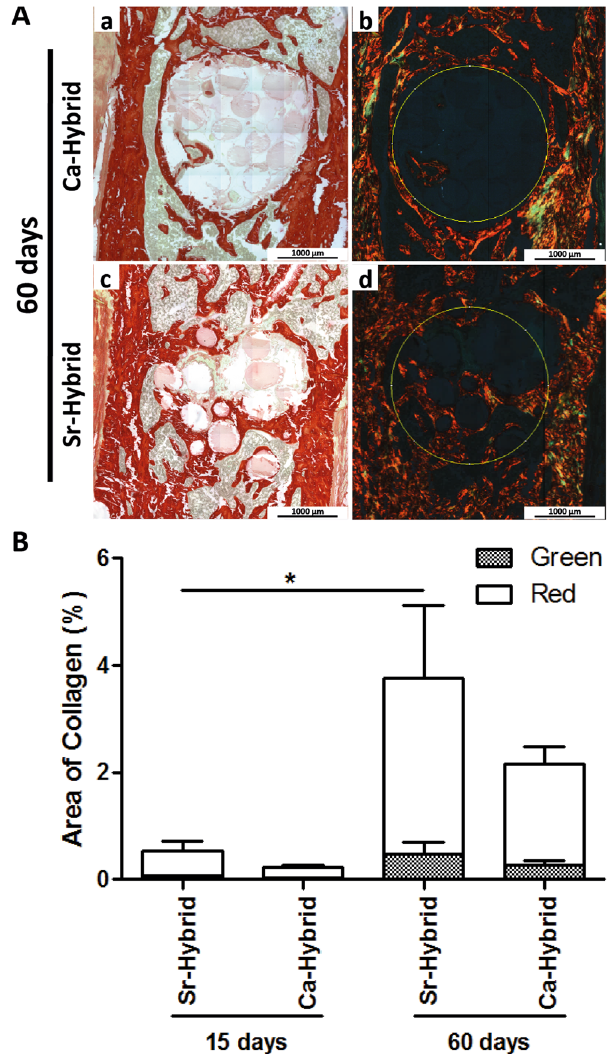
Figure 6. Quantification of birefringent collagen fibers by PSR-polarization method in the center of the defect. PSR staining visualized under conventional light (a and c) and polarized light (b and d) to identify different collagen fiber types, 60 days post-implantation of Ca-hybrid (a and b) and Sr-hybrid (c and d) systems ( A ). PSR stains collagen in red (conventional light) and collagen fibers are specifically birefringent in polarized light (green - thin fibers/type III; red - thick fibers/type I, MosaicX image, original magnification 20x). Fixed region of interest (ROI) used for quantification is demonstrated in b and d. ( B ) Quantification of area of green or red birefringent collagen fibers in the center of the defect in Sr-hybrid and Ca-hybrid filled defects, 15 and 60 days post-implantation. Data presented as mean ± SE of n = 5 animals/group, 3 images/animal. Asterisks show statistically significant differences (p < 0.05) between groups for red collagen